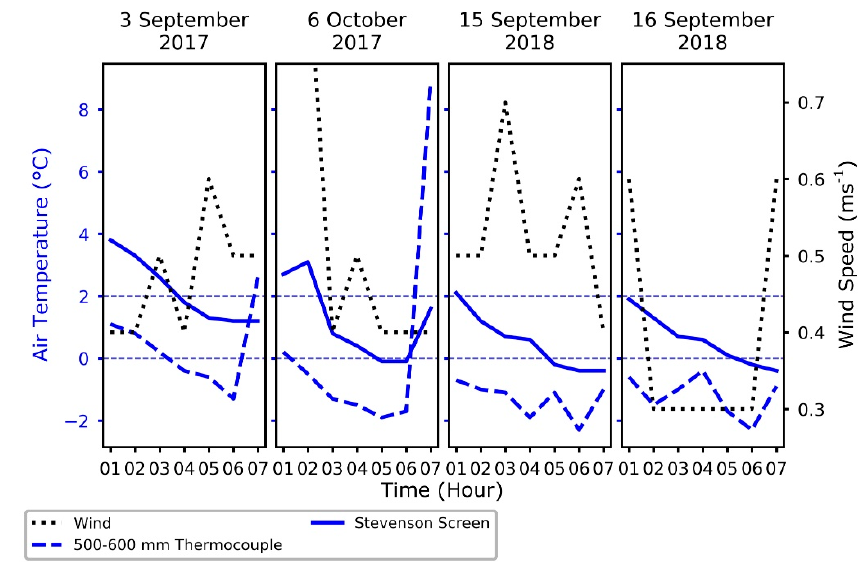
Figure 4. Dale weather station data for the 3 September and 6 October 2017 and 15, 16 September 2018, with light blue dotted line at 2 ◦ C and 0 ◦ C to show how frost is categorized at screen height. Note: In 2017 the weather station thermocouple was at 600 mm AGL and at 500 mm AGL in 2018.